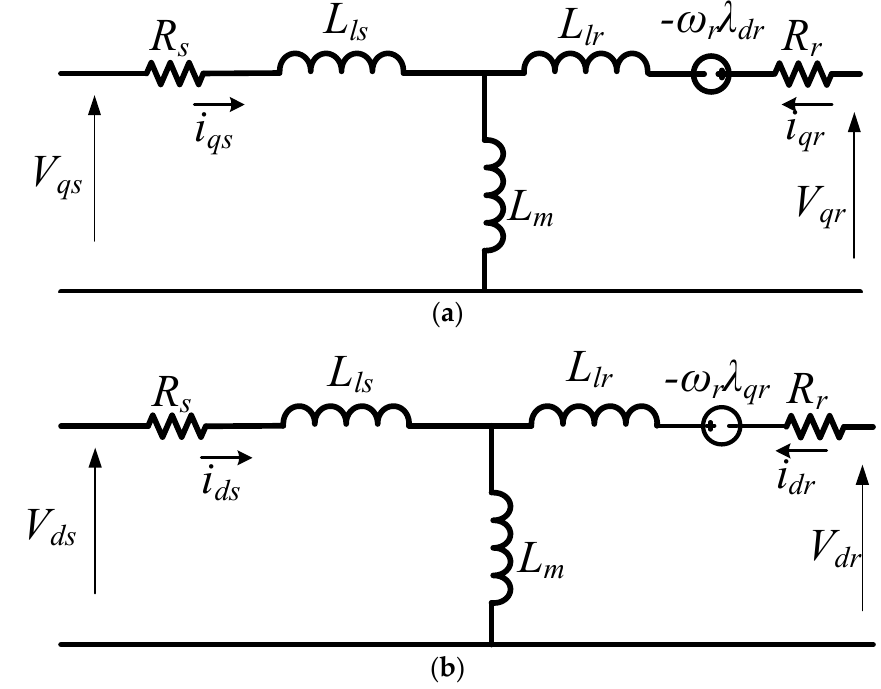
Figure 1. Equivalent circuit of induction motor (IM) in in stationary reference frame (( a ) q-axis and ( b )